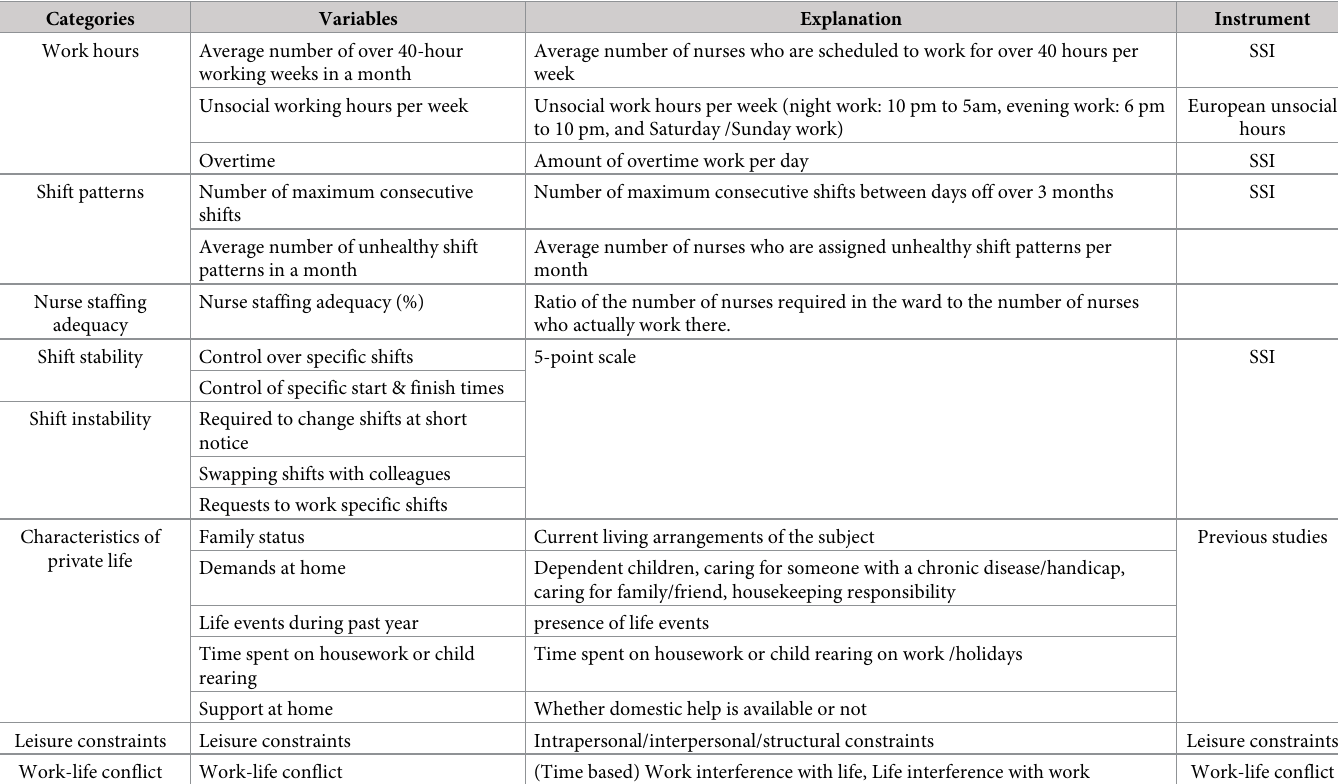
Table 1. Research variables for shiftwork characteristics, aspects of private life, and work-life